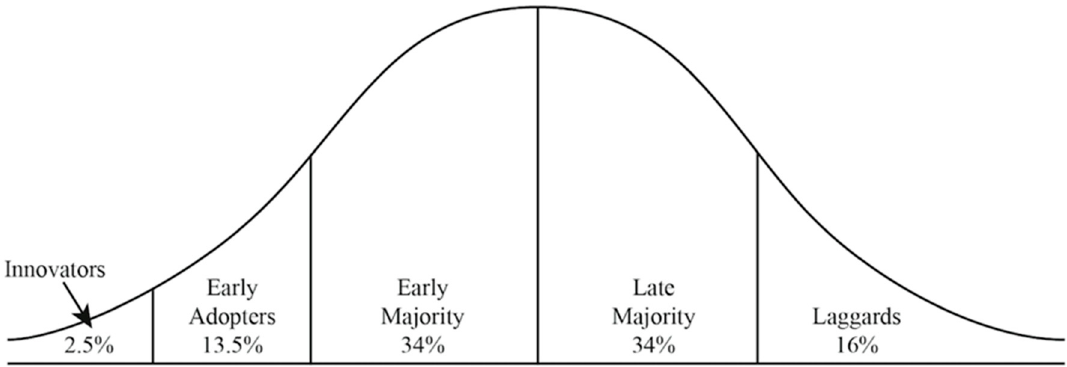
Figure 7. Law of diffusion curve, adapted from Rogers [55].